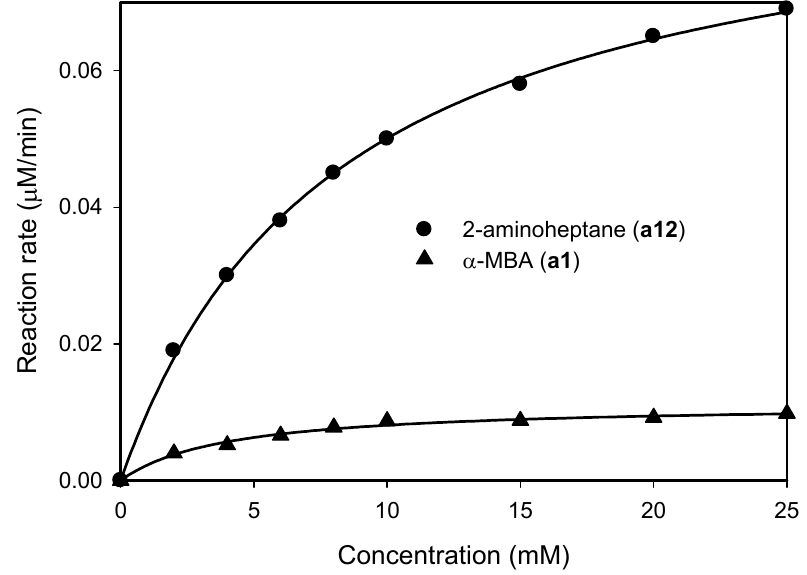
Figure 3. Michaelis–Menten plot of the reaction rate depending on the substrate concentration. The reactions were carried out in 100 mM Tris/HCl (pH 8.5) containing substrate (0–30 mM), AmDH (0.3 mg/mL for a12 , 0.45 mg/mL for a1 ), and 1 mM NAD + at 25 °C.